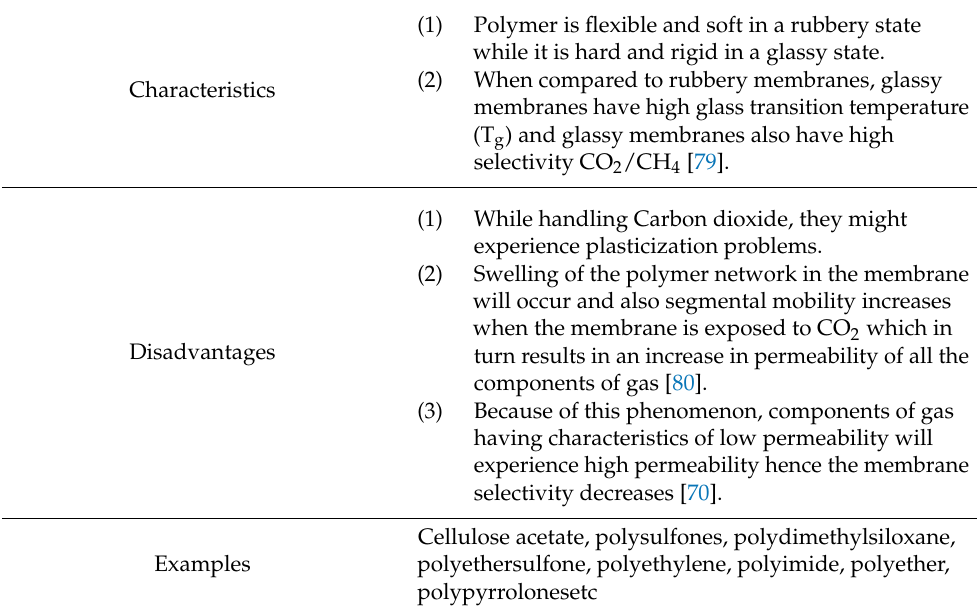
Table 3. Characteristics, disadvantages and types of polymeric